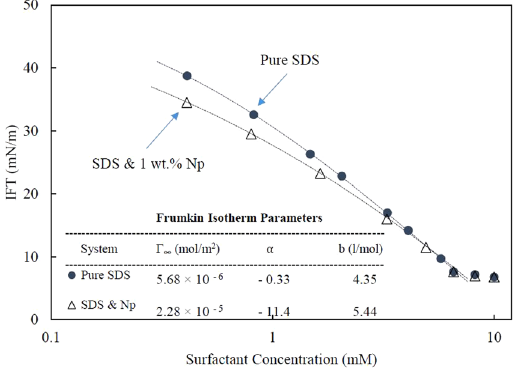
Figure 7. The effect of nanoparticles (Levasil 100/45, 30 nm, 1 wt.%) on equilibrium interfacial tension of heptane/SDS solution as a function of SDS concentration. The dotted lines represent the Frumkin isotherms with the fitting parameters shown in the figure ( Γ : adsorption, α : intermolecular interactions and b: adsorption equilibrium constant). The average error for each experiment is less than 0.5